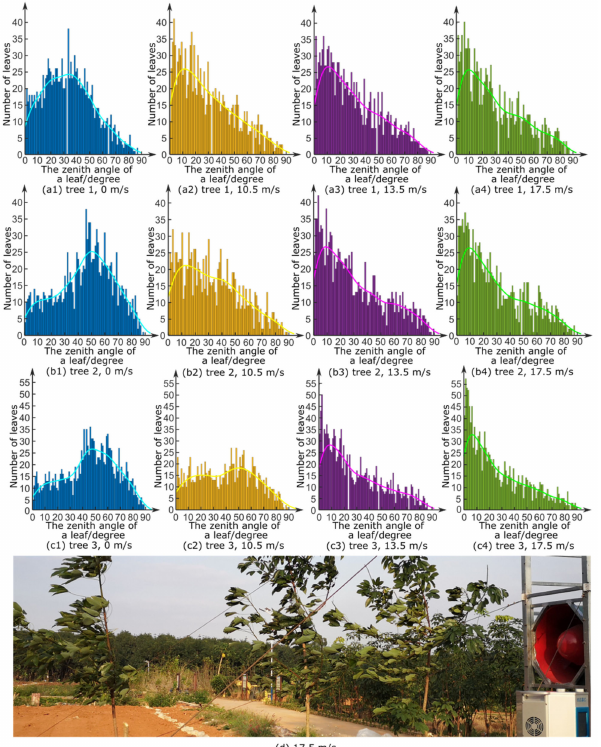
Figure 7. ( a1 – c4 ) illustrate the distribution of the zenith angle for individual leaves of the three rubber trees under various wind loading at four speeds, i.e., 0 m/s, 10.5 m/s, 13.5 m/s, and 17.5 m/s, respectively. ( d ) is a photo showing the effect of the simulated wind speed on the rubber trees under a wind speed of 17.5